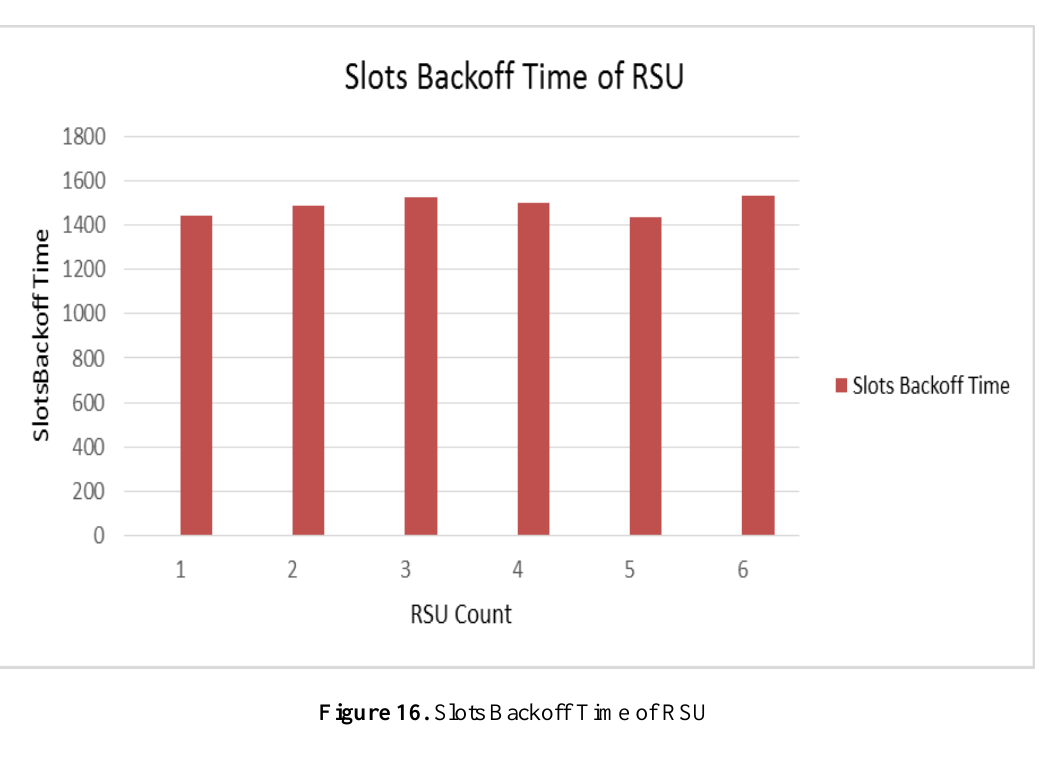
Figure 16. Slots Backoff Time of RSU